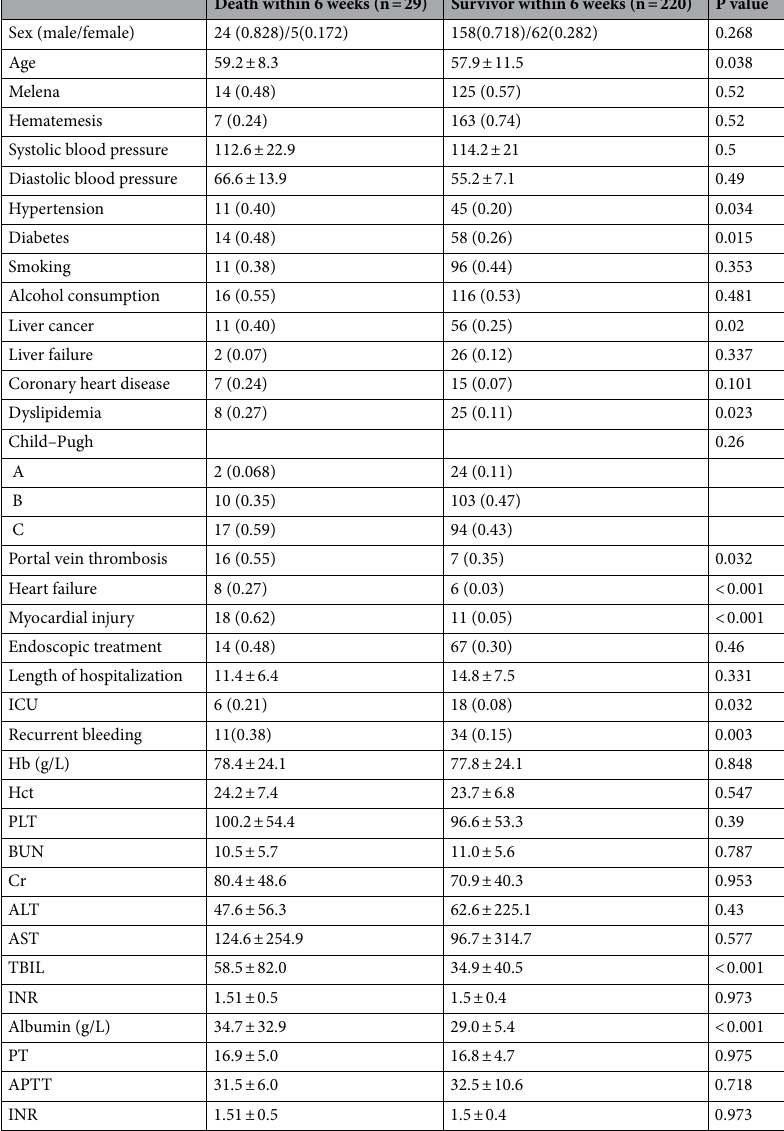
Table 1. Characteristics of patients in term of death within 6